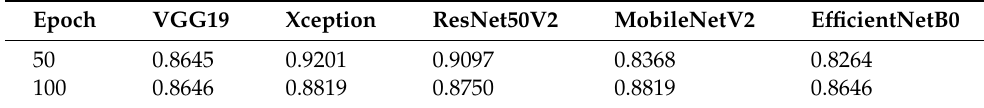
Table 7. Model performance for epochs 50 and 100 (accuracy).